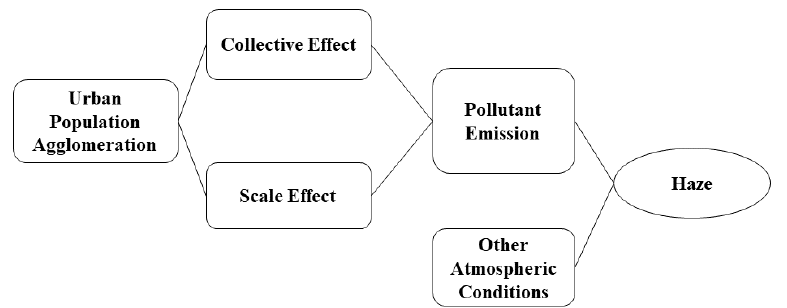
Figure 1. Schematic Diagram of Two Action Mechanisms of Urban Population Agglomeration on Haze Pollution.